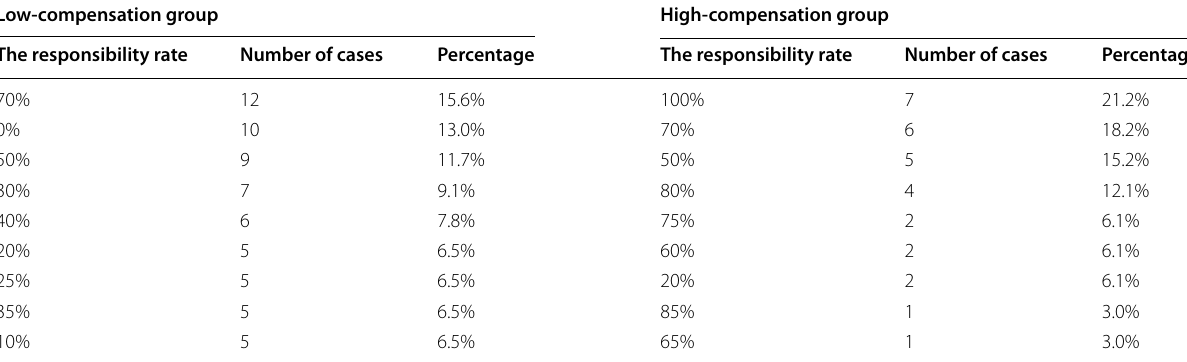
Table 7 Differences in the responsibility rate between the high- and low-compensation groups Low-compensation